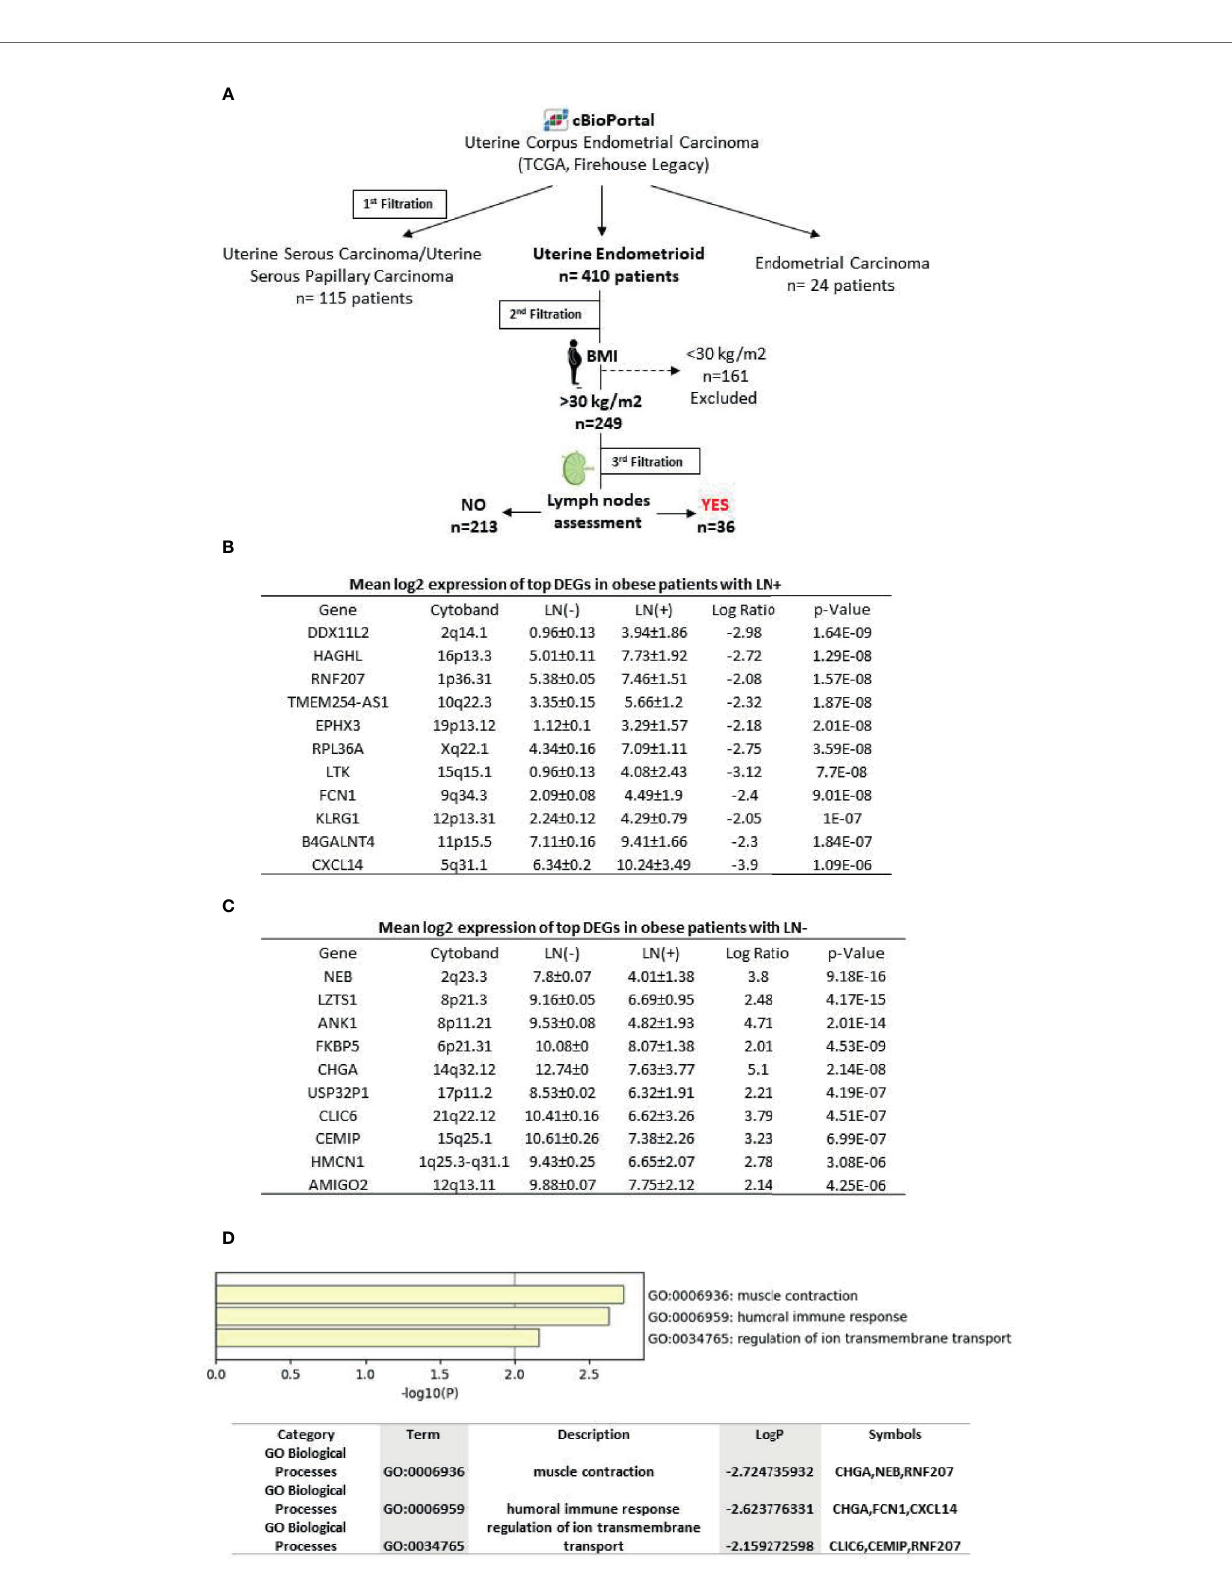
FIGURE 1 | (A) Schematic work fl ow describing biomarker discovery, (B) Log2 expression levels of the differential expressed genes discovered in LN+ patients (C) Log2 expression levels of the differential expressed genes discovered in LN- patients, (D) Pathway analysis of differentially expressed genes using metscape tool for the retrieval of interacting genes. Enriched biological process and molecular functions of those proteins are